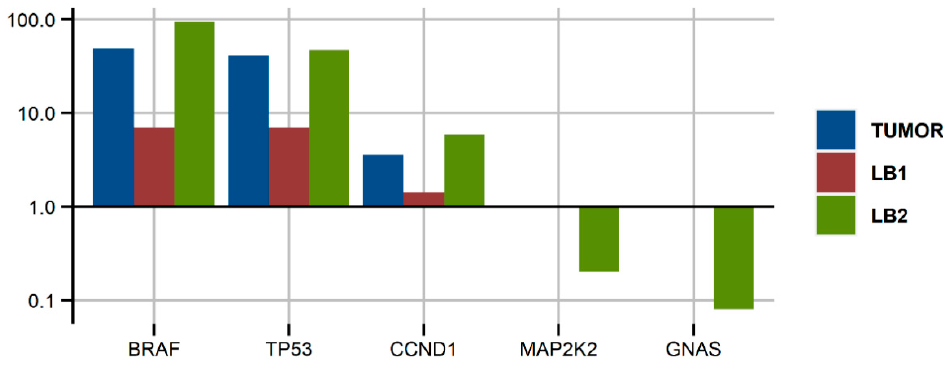
Figure 3. Variant allele frequency of the mutations (for BRAF , TP53 , MAP2K2 , and GNAS ) and copy number variations ratio (for CCND1 ) detected in various samples of Patient #1; LB—liquid biopsy.